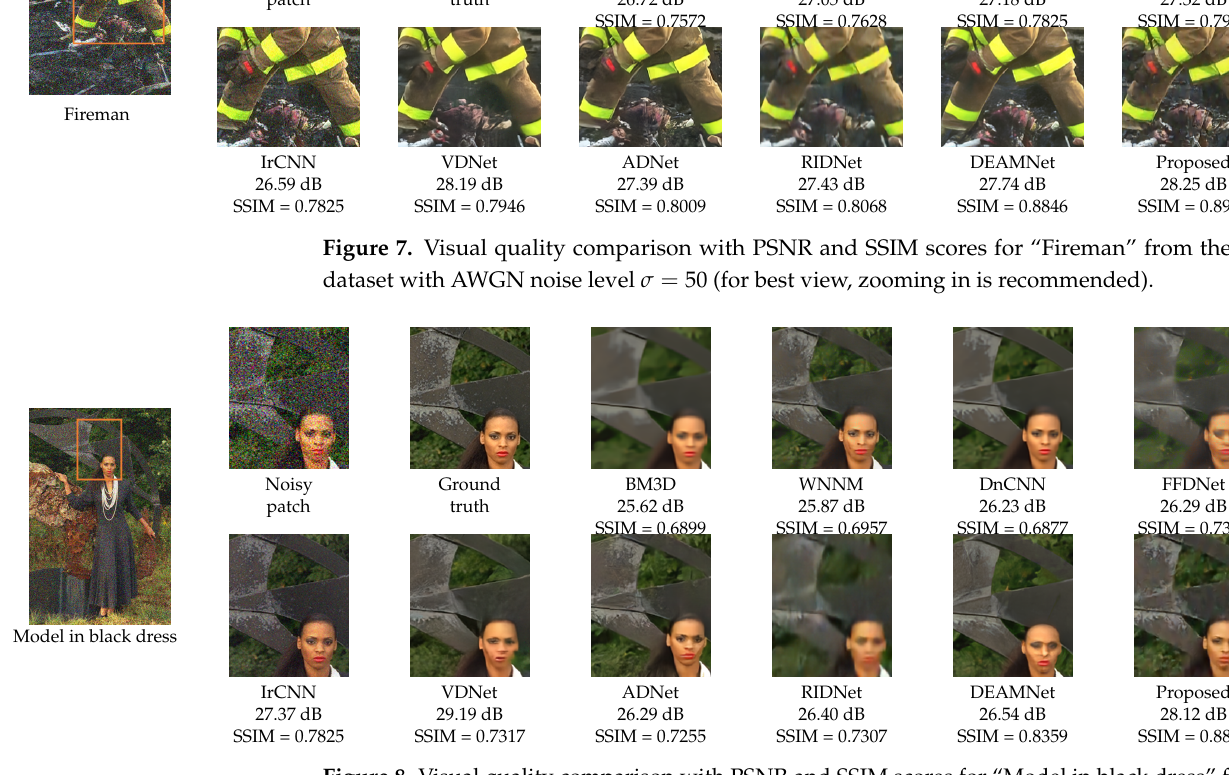
Figure 8. Visual quality comparison with PSNR and SSIM scores for “Model in black dress” from the Kodak24 dataset with AWGN noise level σ = 50 (for best view, zooming in is recommended).